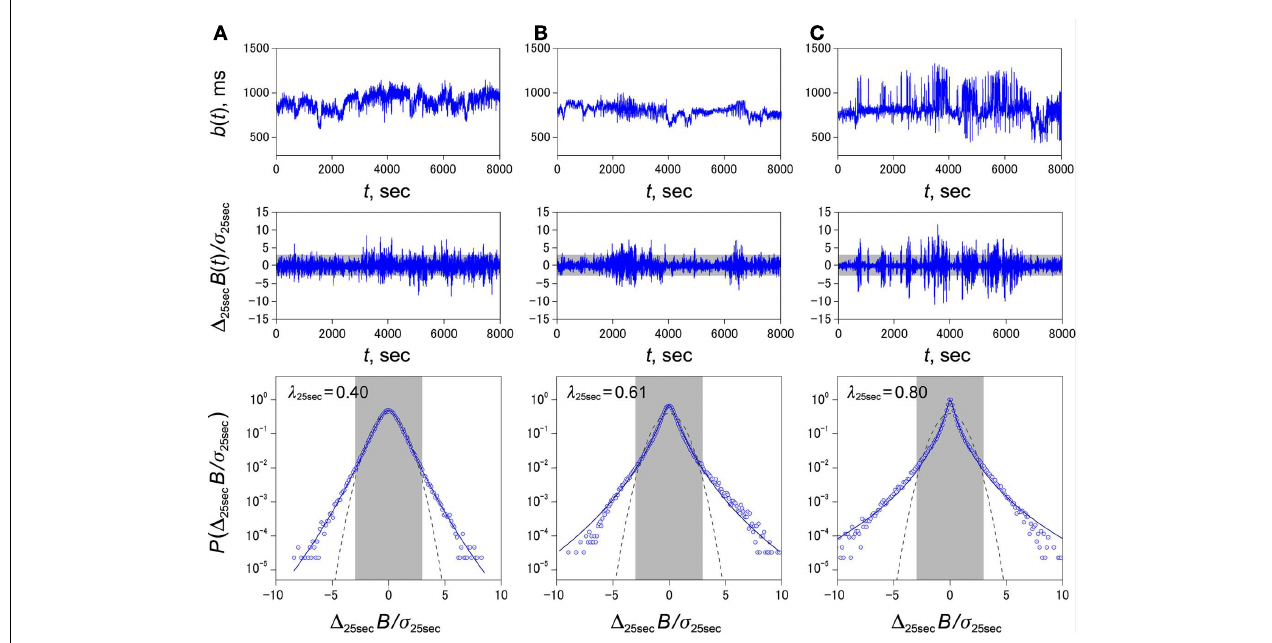
FIGURE 1 | Representative examples of non-Gaussian heart rate fluctuations with different values of λ 25s in post-AMI patients, survivor (A) and cardiac death (B, C). Trend graphs of normal-to-normal sinus rhythm interval (Top row), standardized time series of heart rate increments { Δ 25s B( t )} (middle row), and standardized PDFs of heart rate increments { Δ 25s B( t )} (bottom row). Estimated values of the non-Gaussianity index of λ 25s are shown in each panel in the bottom row. In the solidline, we superimposed the PDF approximated by a non-Gaussian model (Kiyono